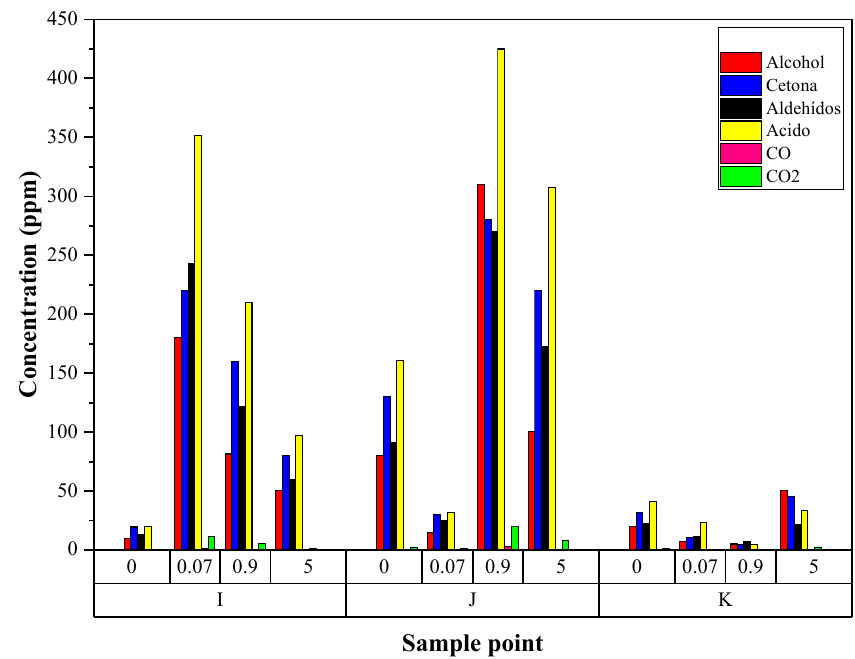
Figure 3. Gases removed in the purge